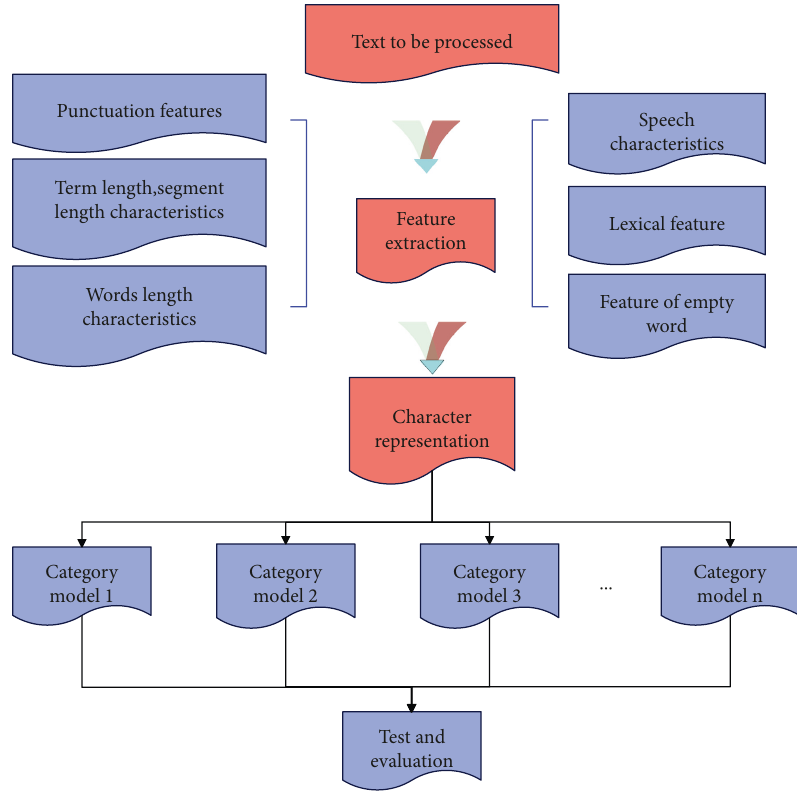
Figure 4: Detailed flowchart of the